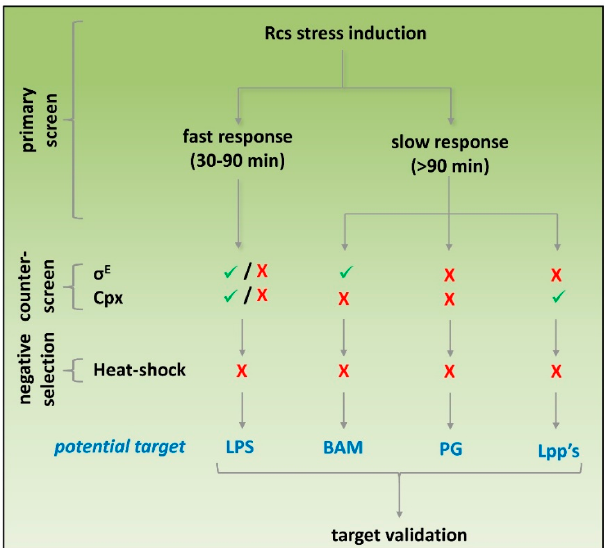
Figure 6. Potential screening strategy to identify cell-envelope-specific antibiotics. Compounds